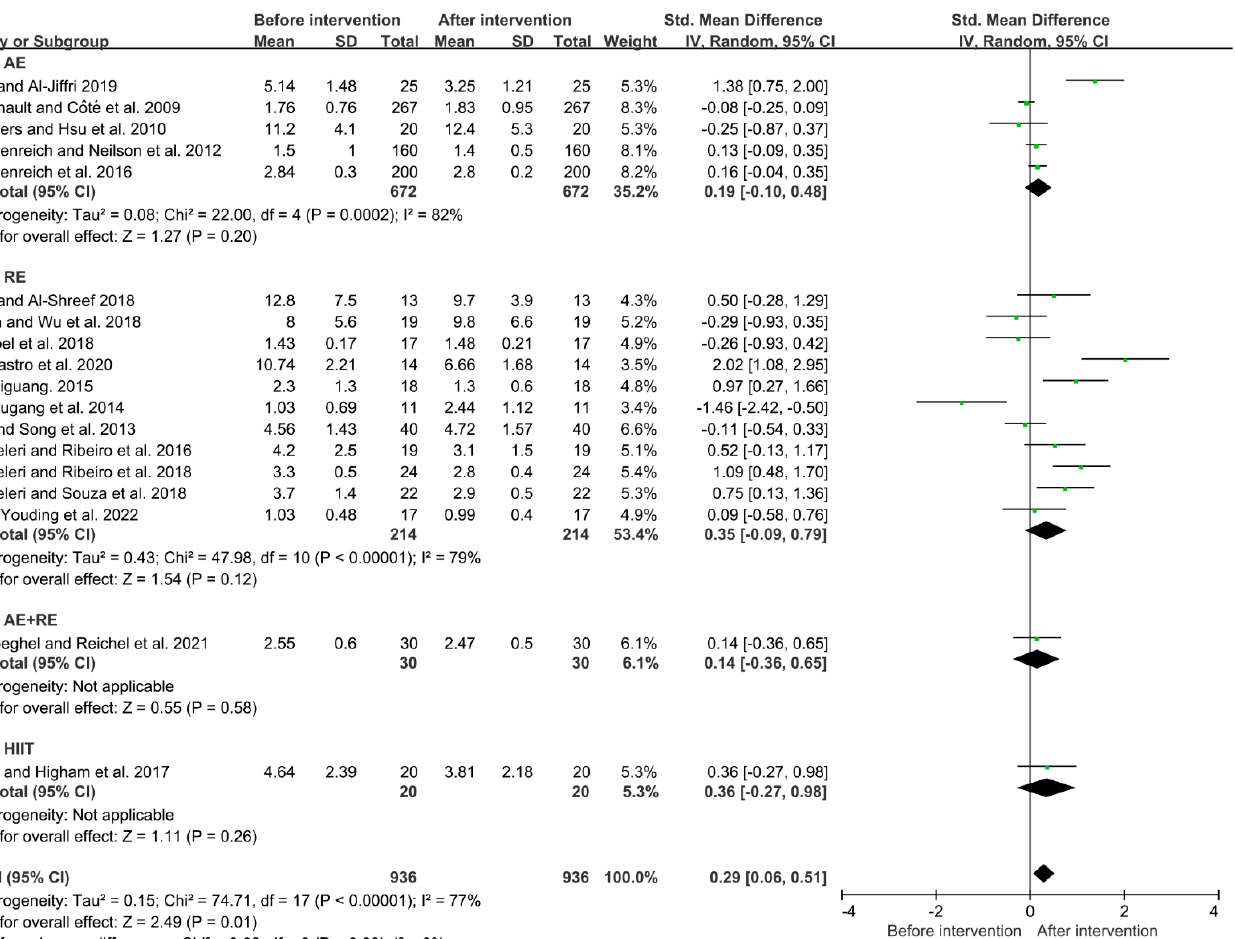
Figure 5. Effects of different exercise modes on TNF- α in the elderly [7,14,16,17,21,23,24,26,28,30– 35,39,40,42].